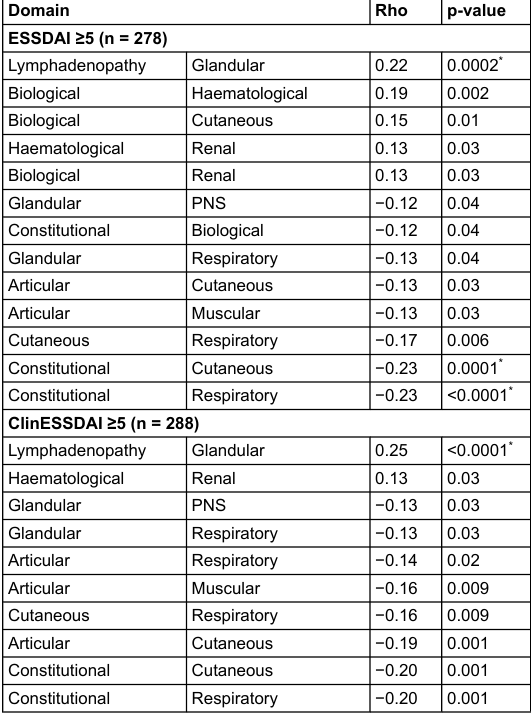
Table 3: Correlation coefficients with p<0.05 between domains in par- ticipants in the UKPSSR with an ESSDAI (n = 278) or ClinESSDAI (n = 288) score ≥5.